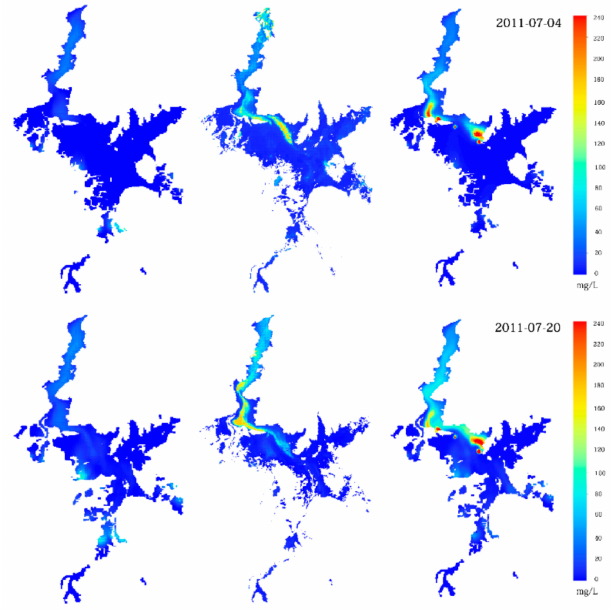
Figure 9. Comparison of the SSC spatial distribution, simulated with (left) or without (right) dredging, and MODIS derived (center) on July 4 and 20,